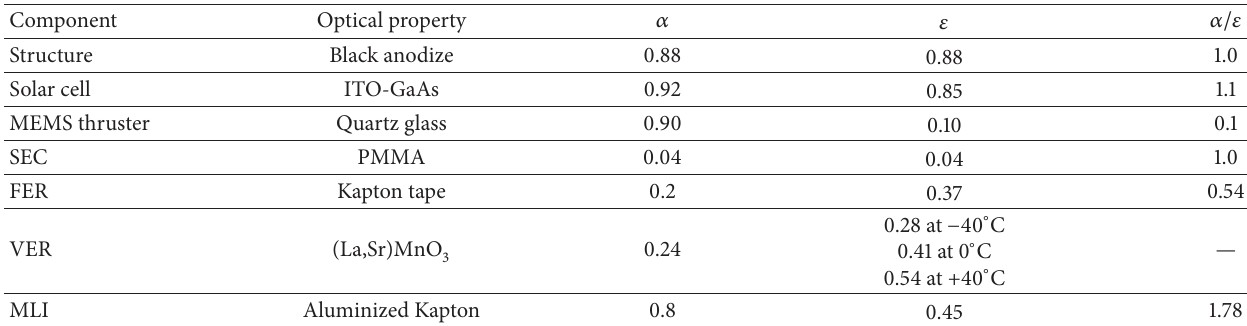
Table 6: Summary of thermooptical properties used in the